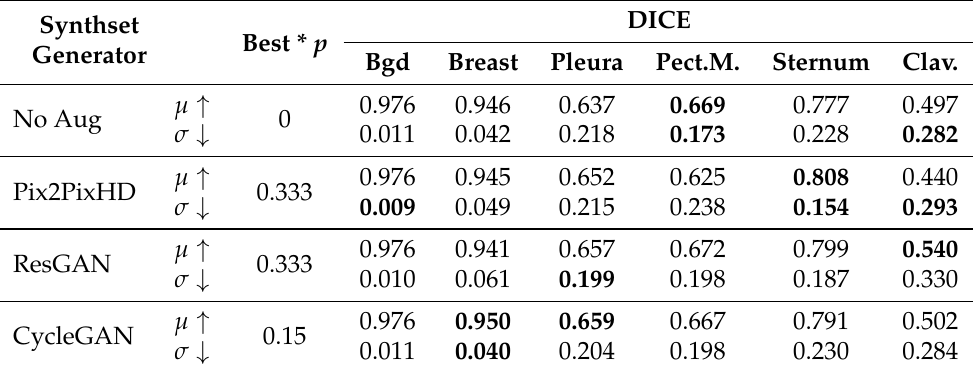
Table 4. Class-wise segmentation test scores. Presents the best DICE mean ( µ ) and standard deviation ( σ ) results for the labels: Background, Breast, Pleura, Pectoral Muscle, Sternum and Clavicules, respectively, for the augmentation experimental setups of each generator. The no augmentation baseline ( No Aug ) is also shown.